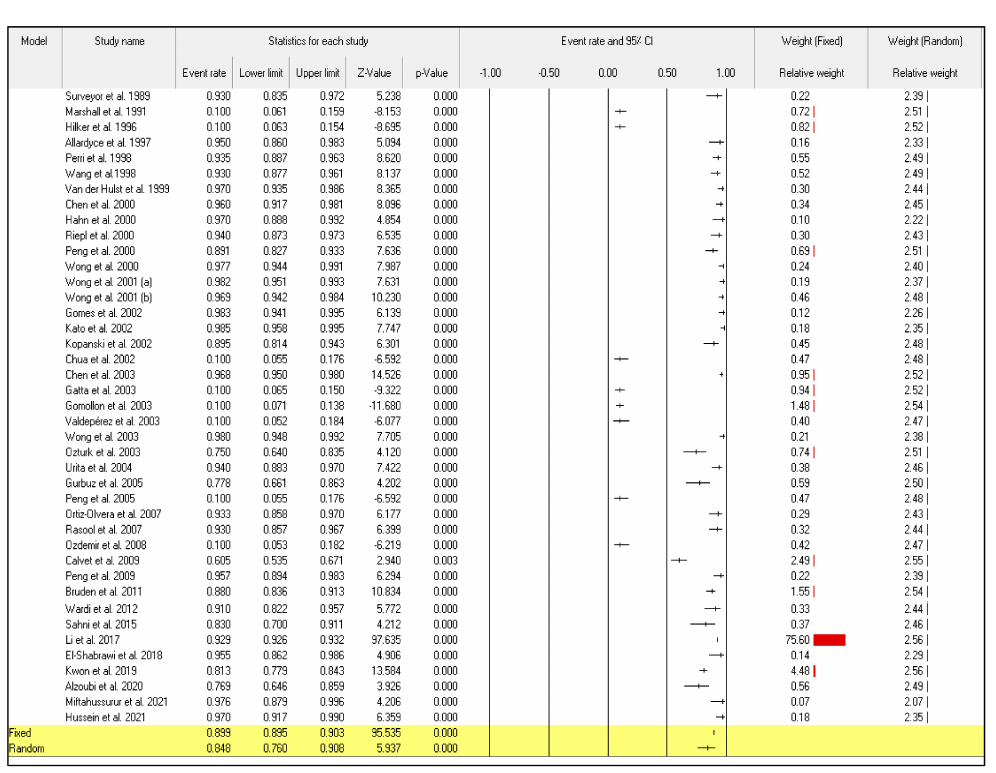
Figure 2. Forest plot from the fixed and random-effects analysis: the sensitivity of 13 C/ 14 C-urea breath tests in the diagnosis of Helicobacter pylori infection [32–72].